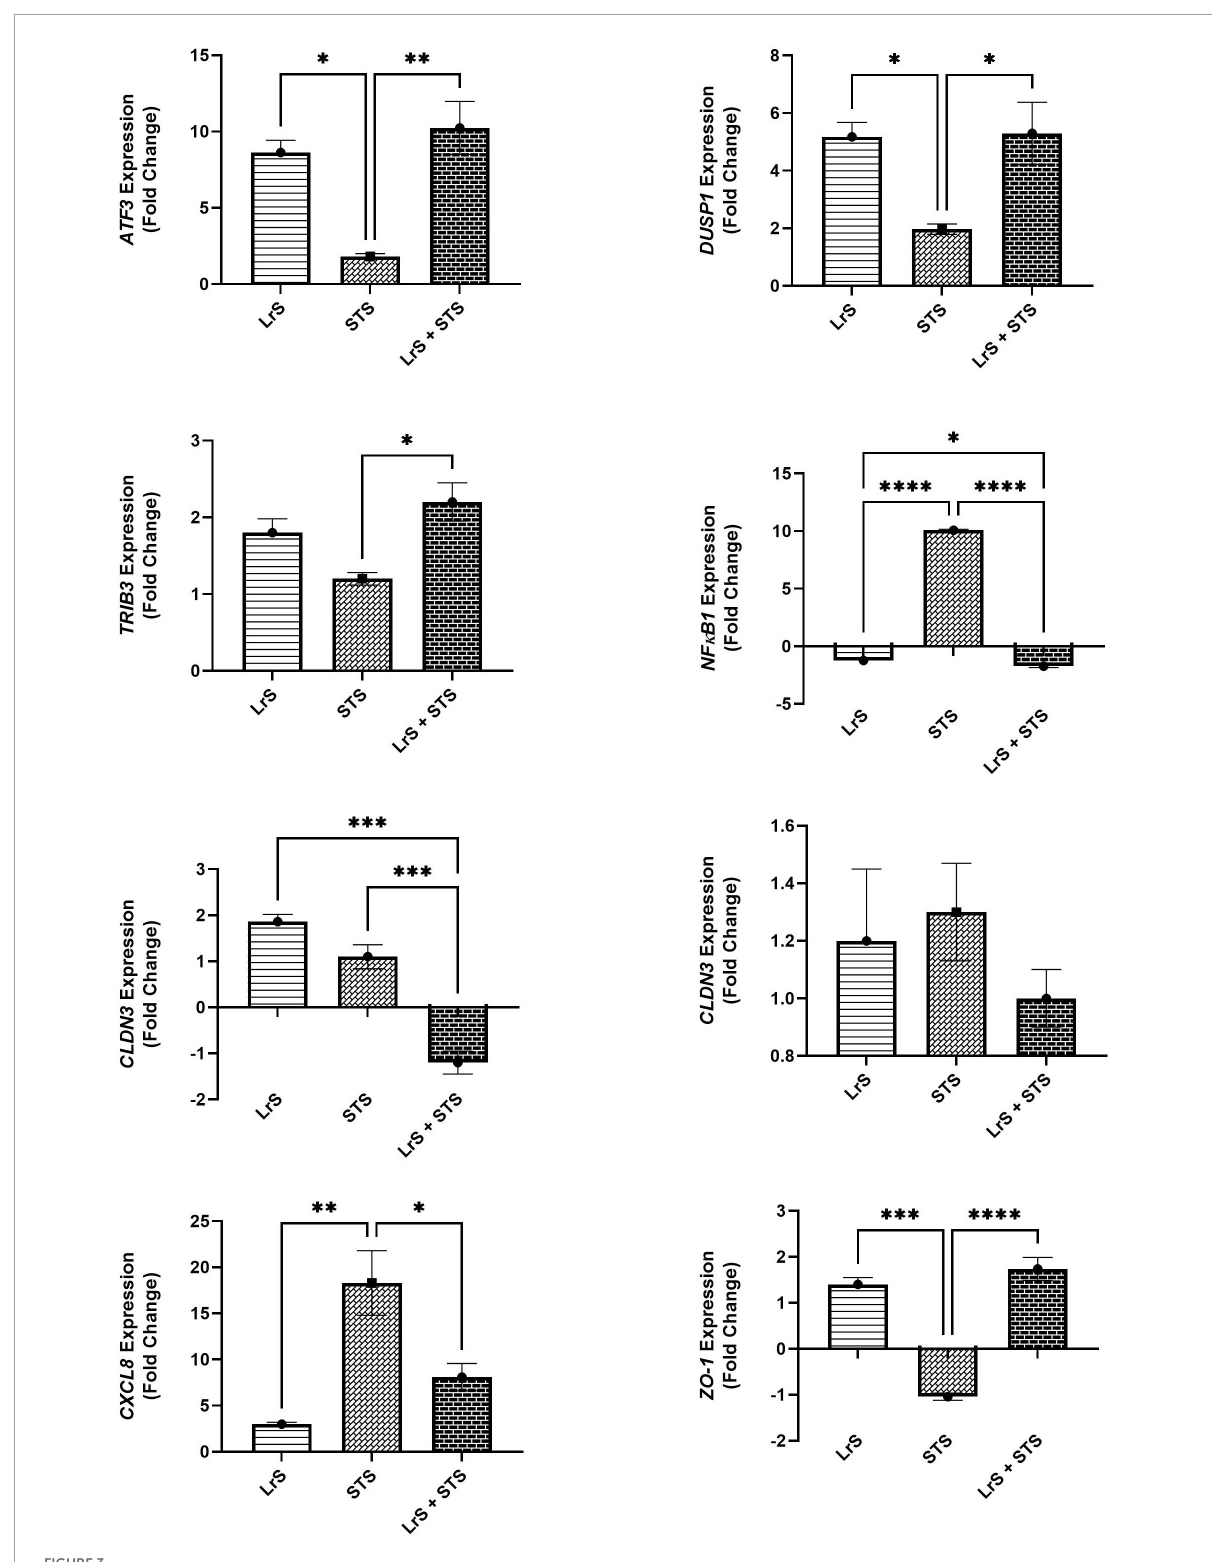
FIGURE3 Gene expression profiles of T84 IECs in T84 IEC/THP-1 monocyte co-cultures challenged with the LrS, STS, or a combination of the challenges. Data shown is the mean fold- change relative to untreated controls ± SEM ( n = 4). Significance is indicated as ∗ p < 0.05, ∗∗ p < 0.01, ∗∗∗ p < 0.001, ∗∗∗∗ p < 0.0001 as determined by one-way ANOVA and Tukey’s post-hoc